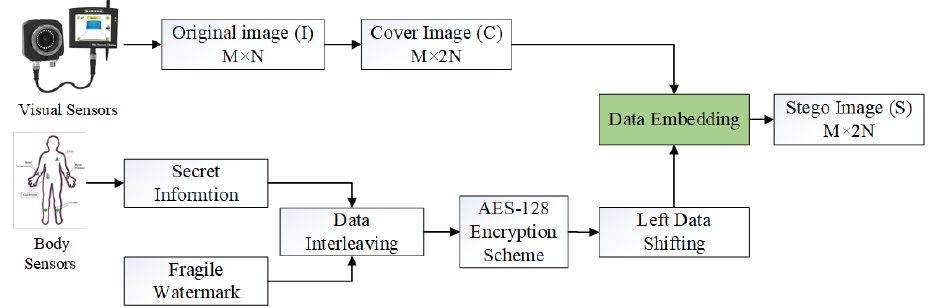
Figure 2. Block diagram of the proposed scheme.